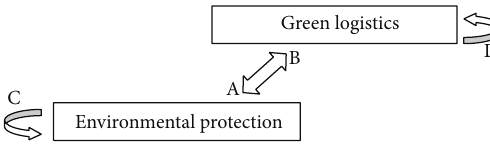
Figure 2: The causal evaluation